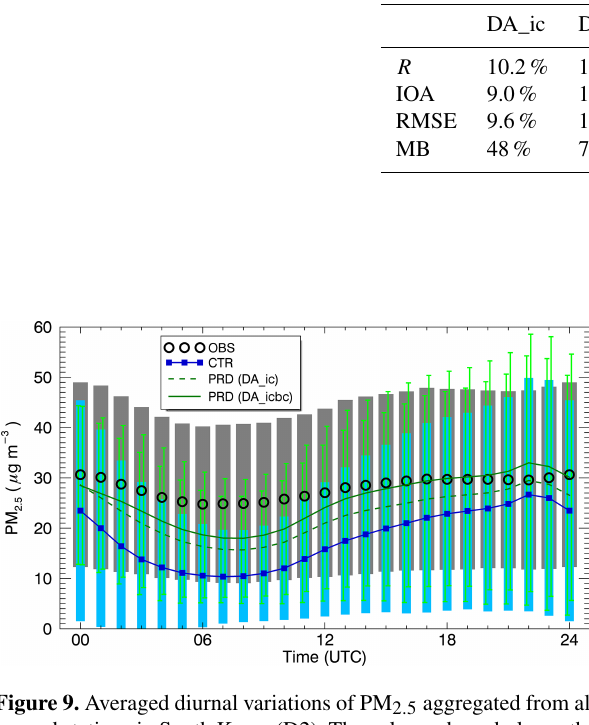
Figure 8. Daily averaged variations of PM 2 . 5 . The lines and colors are the same as in Fig. 3, except for the 1d prediction runs (PRD). The 1d predictions only with updated initial conditions (DA_ic) and with initial and boundary conditions (DA_icbc) are presented by the dashed and solid green lines, respectively. Table 5. Rate of improvement (ROI) by EnKF data assimilation in 1d predictions. The ROI is the ratio of the enhanced ( R and IOA) or reduced (RMSE and MB) statistical metrics to those for the CTR simulation. The ROI by updating boundary conditions (DA_bc) can be estimated from the difference between that obtained by the DA_ic and DA_icbc experiments.